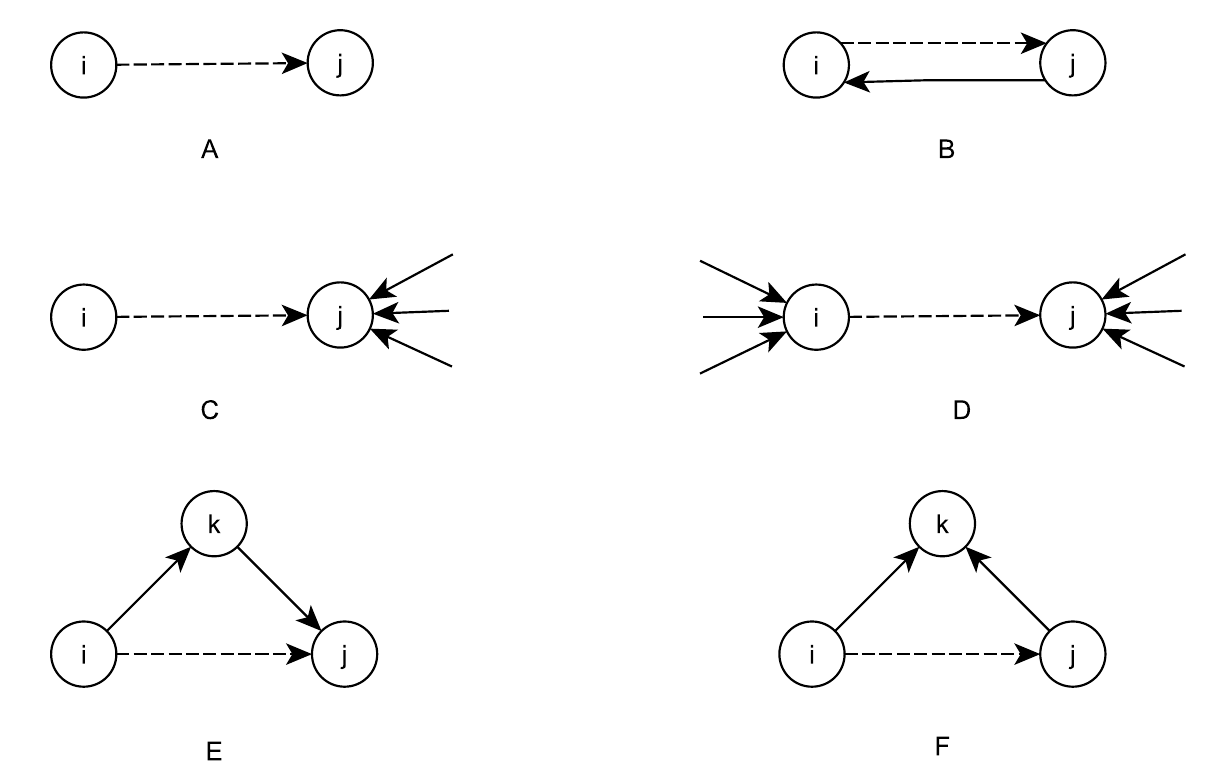
Fig 4. Illustrations of different mechanisms considered. (A) parameter q , (B) mutuality mechanism, (C) popularity mechanism, (D) assortativity mechanism, (E) transitivity mechanism, (F) outgoing-shared-partners mechanism.